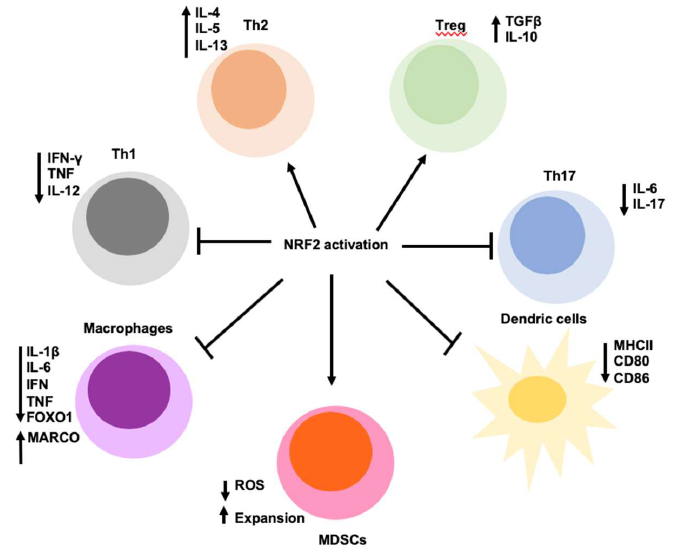
Figure 4. NRF2 regulates inflammation and immunity. The activation of NRF2 may alter the differentiation, expansion, and survival of the immune cells as well as the cytokine release. NRF2 activation shifts Th1/Th2 balance in disease models by impairing Th1-driven response and skews them towards Th2 differentiation. NRF2-mediated antioxidant defense in Treg cells leads to their expansion and survival. Nfe2l2 -deficiency leads to elevated oxidative damage that exacerbates the differentiation of Th17 cells. Nfe2l2 deletion in dendritic cells augments expression of MHC class II and the cells surface expression of co-stimulatory molecules CD86 and CD80 to influence the behavior of Th cells. Increased NRF2 expression in leukocytes such as macrophages inhibits the expression of pro-inflammatory genes through down-regulation of the NF-κB pathway. NRF2 activation in MDSCs regulates metabolism that leads to expansion of suppressive MDSCs. However, Nfe2l2 -deletion in MDSCs have higher levels of intracellular ROS that suppress CTLs proliferation and induces T-cell anergy.